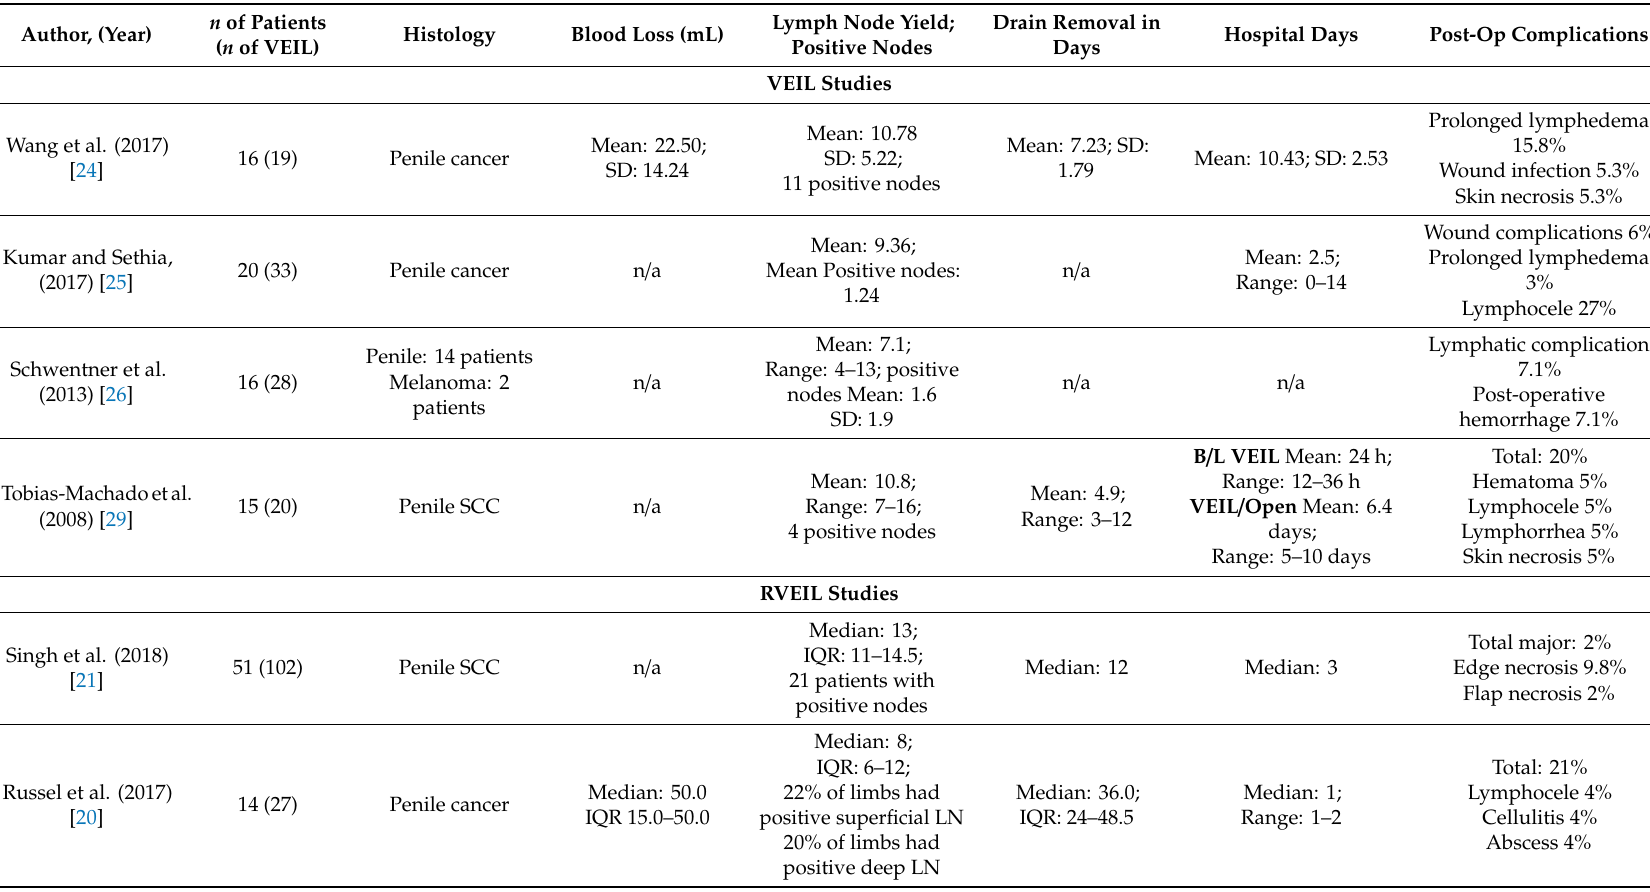
Table A1. Summary of Peri-operative Outcomes for Video Endoscopic Inguinal Lymphadenectomy (VEIL), Robotic-assisted Video Endoscopic Inguinal Lymphadenectomy (RVEIL) and Open Inguinal Lymphadenectomy (OILND)